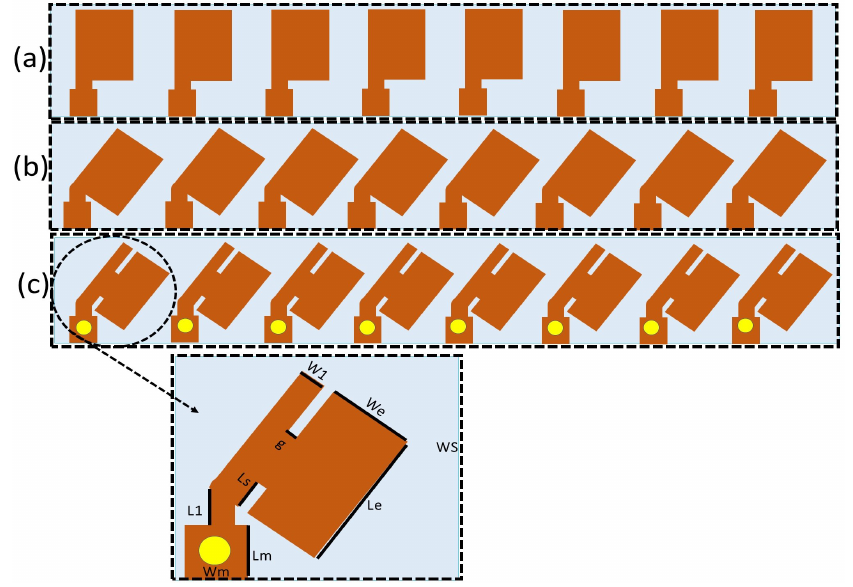
Figure 1. ( a ) Straight elements MIMO. ( b ) Bend elements MIMO. ( c ) Proposed eight-element